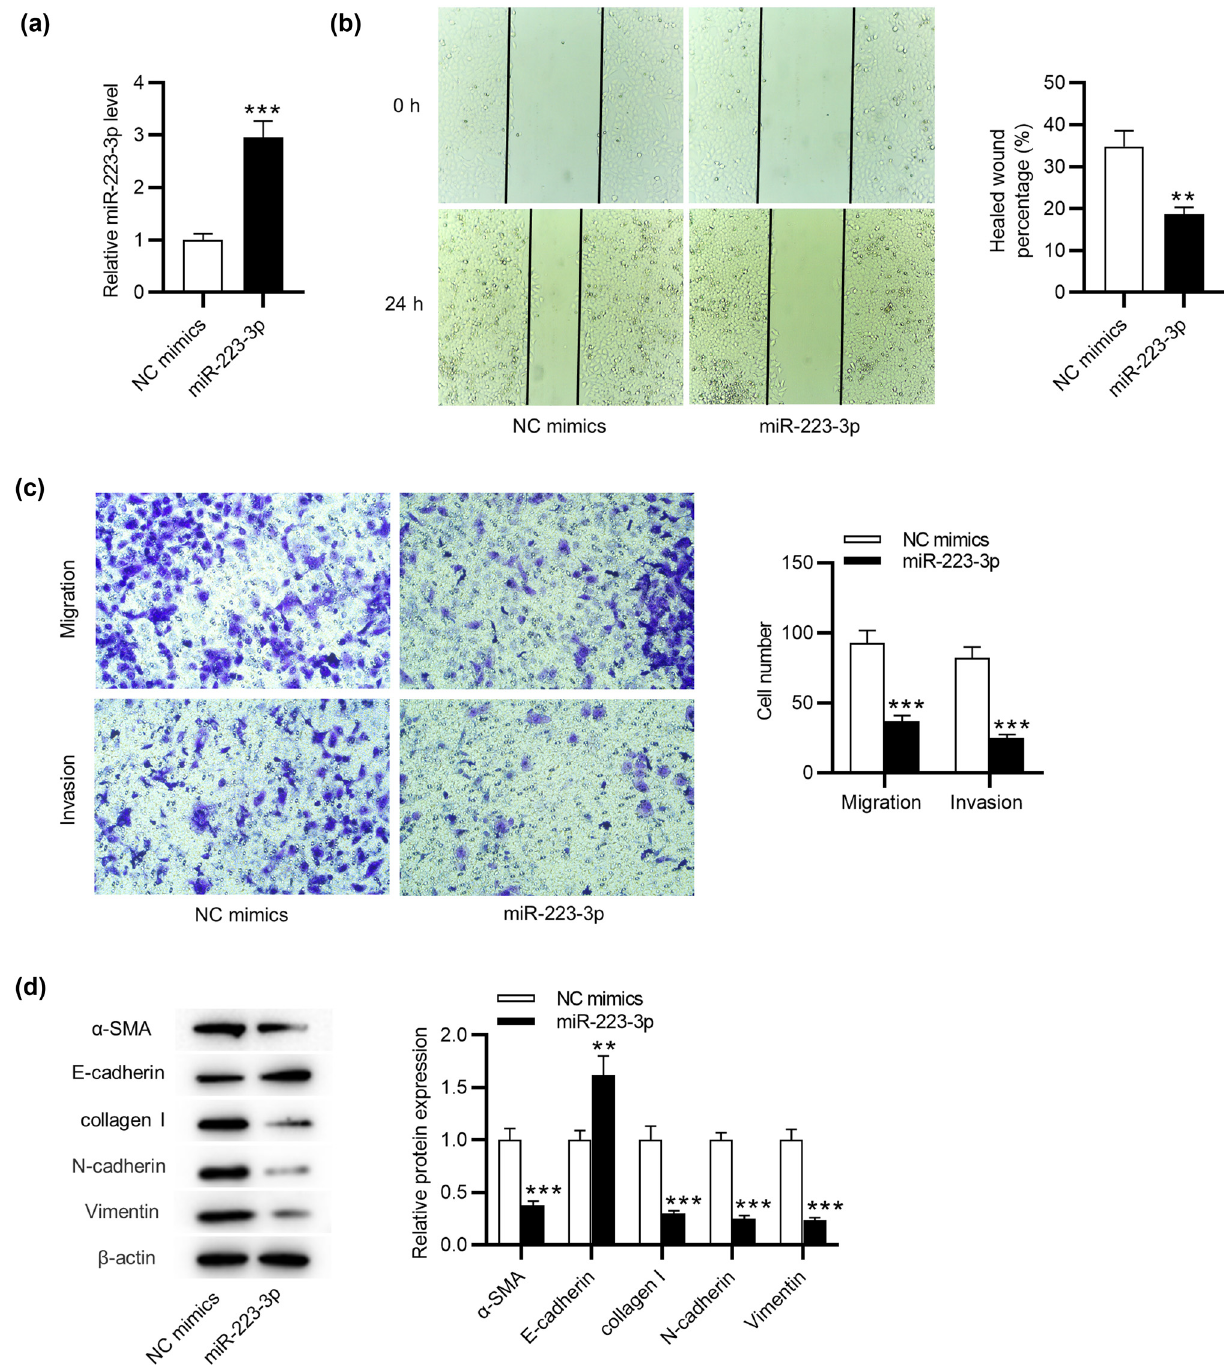
Figure 2: MiR - 223 - 3p alleviates EMT process and ECM deposition. TGF - β - treated EECs were used for the following assays. ( a ) RT - qPCR for detection of the transfection e ffi ciency of miR - 223 - 3p mimics. ( b ) Wound healing assay for detecting cell migration after overexpressing miR - 223 - 3p. ( c ) Transwell assay for evaluating cell migration and invasiveness after transfection of miR - 223 - 3p mimics. ( d ) Western blotting of EMT protein and ECM protein levels in miR - 223 - 3p mimic group and the control group. All experiments were performed in triplicate and data are presented as the mean value ± SD. Student ’ s t - tests were performed for statistical analysis. ** p < 0.01, *** p < 0.001, miR - 223 - 3p vs NC mimics